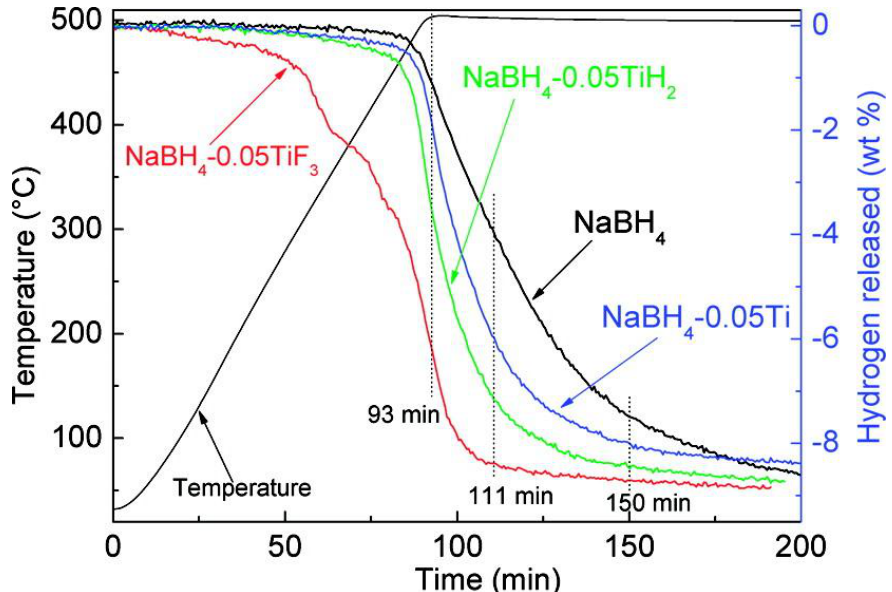
Figure 2. Temperature-programmed desorption (TPD) profiles of NaBH 4 with and without different titanium catalysts. The heating rate was 5 °C·min −1 [32]. Reprinted with permission from [32], copyright 2012 The American Chemical